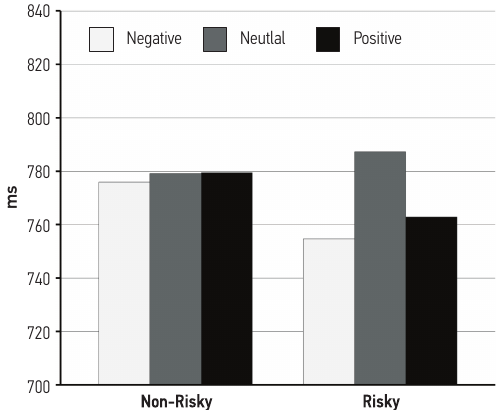
Fig. 3. Response latency (Experiment 2). Average reaction times according to risky situation and emotional warning